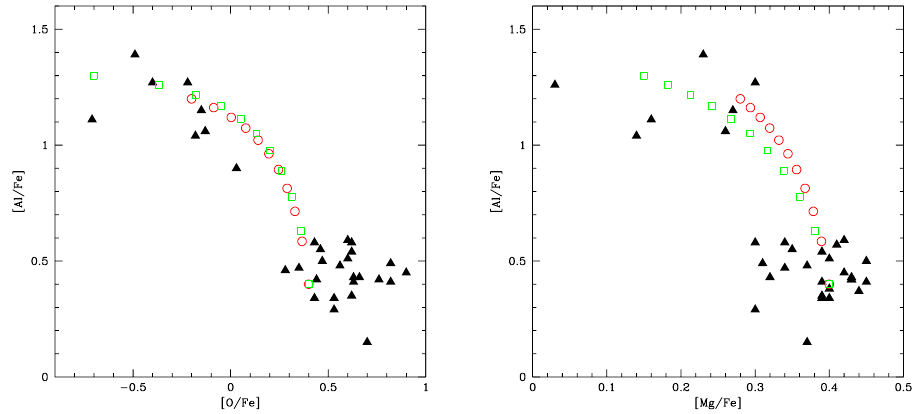
Figure 5. The surface chemistry of NGC 6402 stars by [47], shown in the O-Al ( left panel ) and Mg-Al ( right ) stars. Red points indicate the chemistry obtained by mixing the ejecta from AGBs with different percentages (spaced by 10%) of pristine gas, with the same chemistry of 1G stars. Green points refer to dilution of AGB ejecta obtained by assuming lower rates of mass loss than in the standard evolutionary